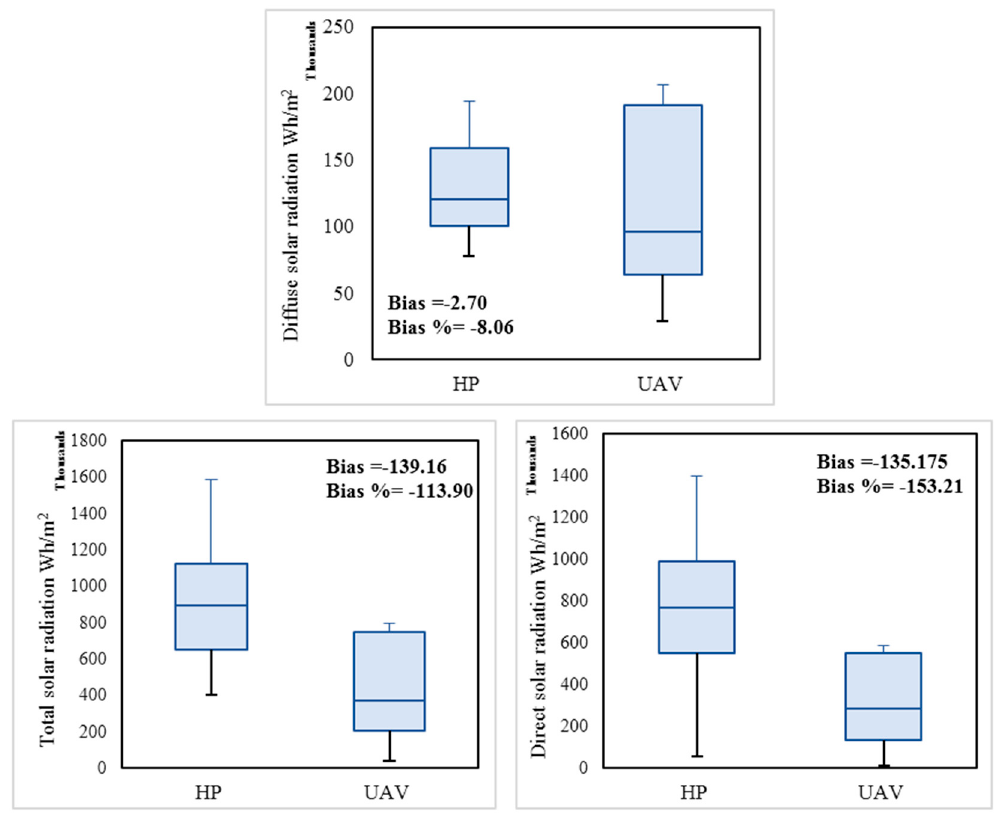
Figure 13. The differences between the mean of potential solar radiation parameters in W · h/m 2 for an entire growing season estimated by HP and the UAV. The median of measured values is marked by a horizontal line inside the boxes. The end of the boxes is the interquartile range (the upper: Q3 and lower: Q1). The whiskers show the highest and lowest observations.